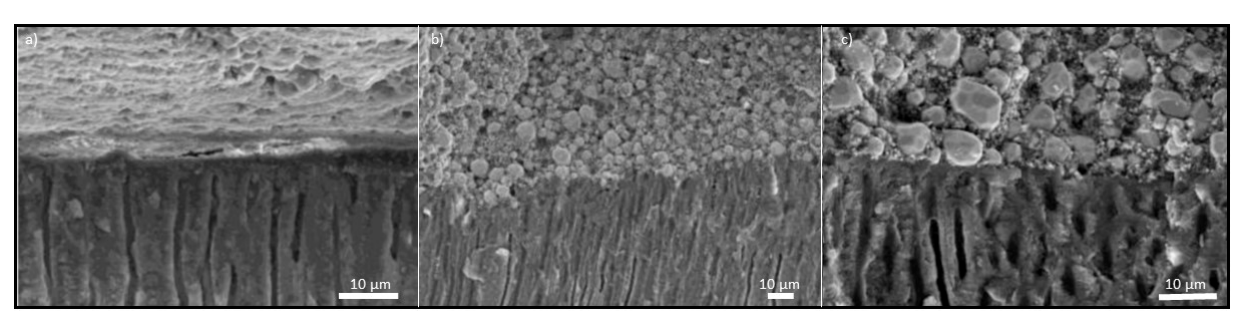
Figure 9. Close connection of the root dentin with a visible cross-section of the dentinal tubules along their axis transverse to the root canal with the filling material based on gutta-percha covered with an intermediate layer of sealant: ( a ) cold condensed; ( b , c ) thermoplastically condensed with THC, viewed with SEM.